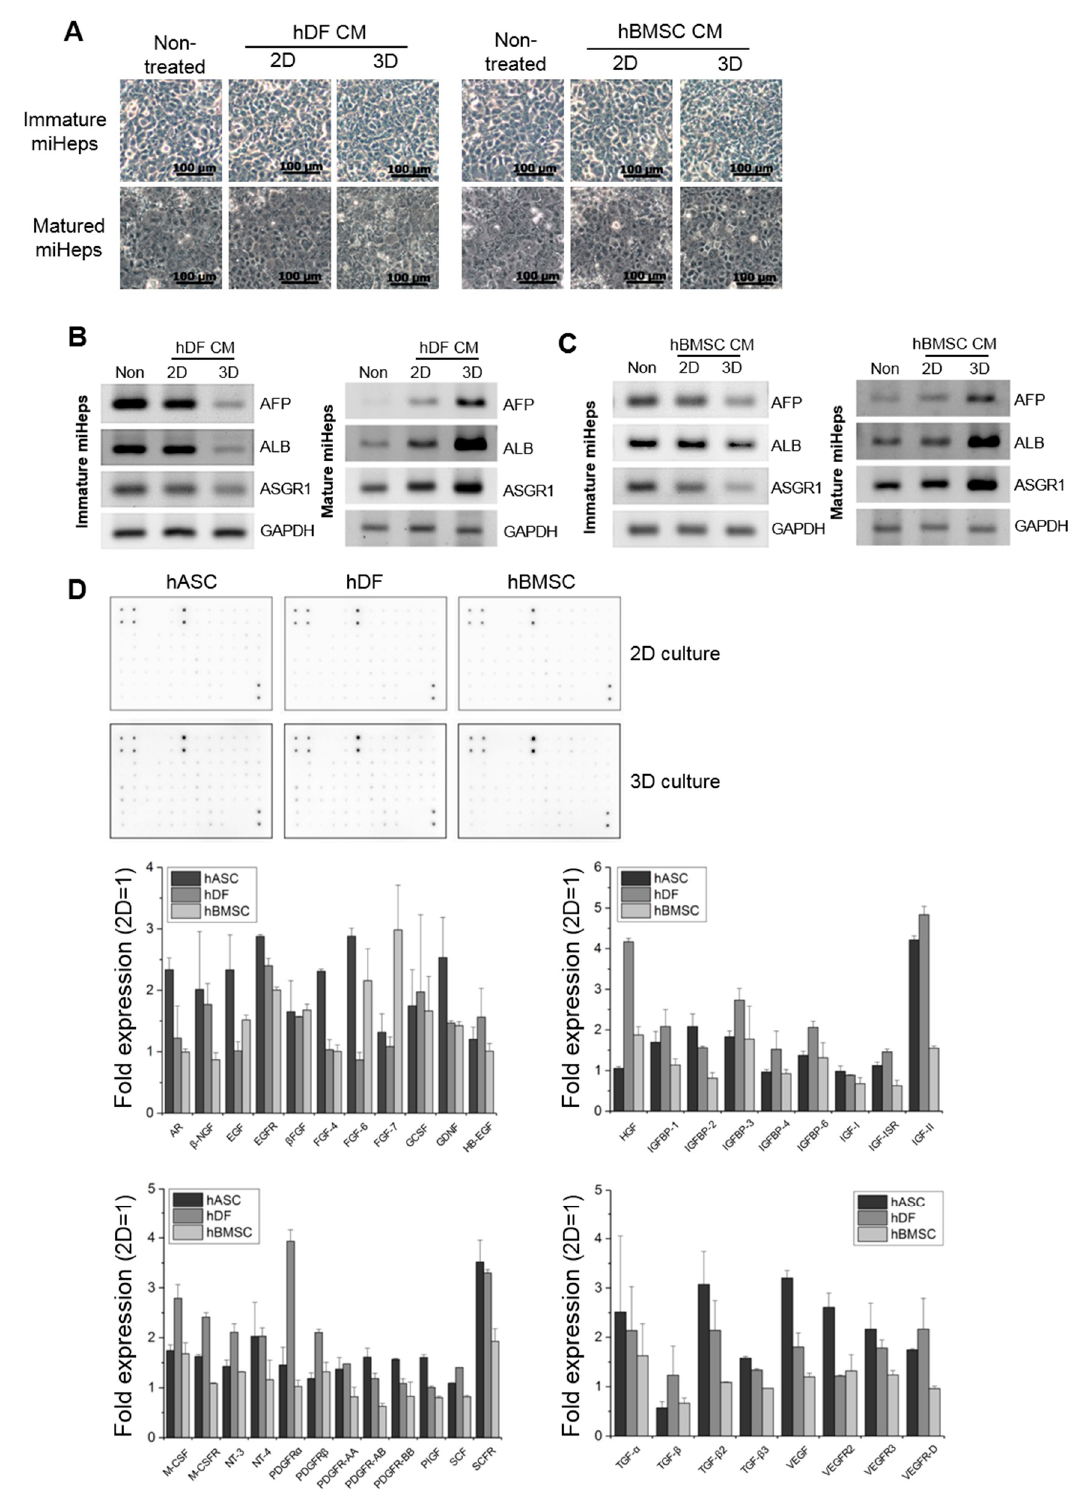
Figure 5. Effects of hBMSC and hDF conditioned media on miHep hepatic function. ( A ) Cell morphology of miHeps treated with the CM of 2D- or 3D-cultured hBMSCs and hDFs; 3D-CM, the CM of 3D-cultured hASCs. Reverse-transcription PCR analysis of hepatic genes in miHeps treated with the CM of hDFs ( B ) and hBMSCs ( C ). ( D ) Dot blot images were acquired from the lysates of 2D- or 3D-cultured hASC, hDF and hBMSC; The intensity of each dot blot was normalized with those of 2D-cultured cells set to one.